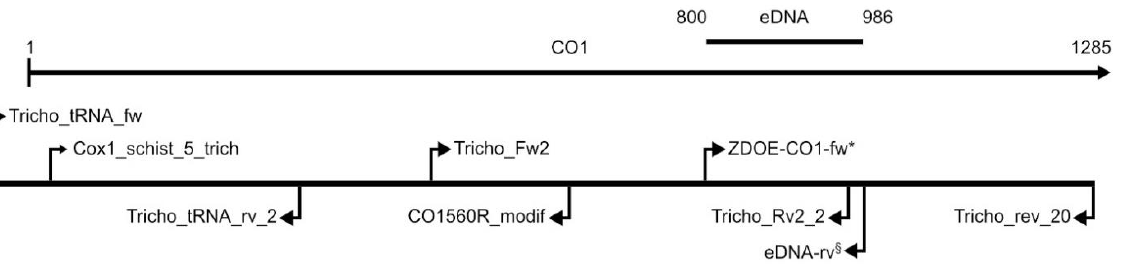
Figure 1. Positions of primers used relative to CO1 of Trichobilharzia szidati (mt genome, GenBank accession number MG570047). The orientations of primers are marked by arrows. The long line on top shows part of the CO1 gene from the gene start (position 1) until the position of the 3 ’ -end of primer Tricho_rev_20 (position 1285). The short line on top illustrates the position of the 186 bp-amplicon used in the eDNA analyses. The asterisk (*) indicates that this is the position of ZDOE-COI-fw_szidati as well as ZDOE-COI-fw_physellae; eDNA-rv § indicates the position of the four primers eDNA- franki-rv, eDNA-regenti-rv, eDNA-szidati-rv, and eDNA-physellae-rv. Table 4. Conditions of PCR reactions as well as amplicon lengths for the different primer pairs. T ann = annealing